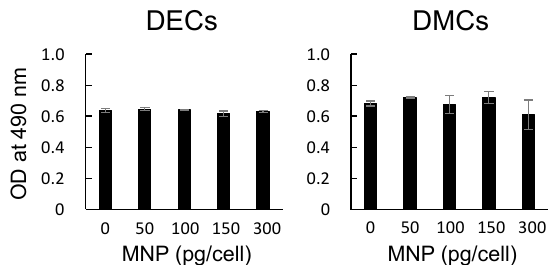
Figure 2. Cytotoxic effects of MNPs on dental epithelial cells (DECs) and dental mesenchymal cells (DMCs) assessed by MTS assays. MNPs at 0, 50, 100, 150, or 300 pg-magnetite/cell were added to the cells at confluency. After the cells were maintained for 24 h in the presence or absence of MNPs, the MTS assay was performed. p > 0.05, ANOVA.